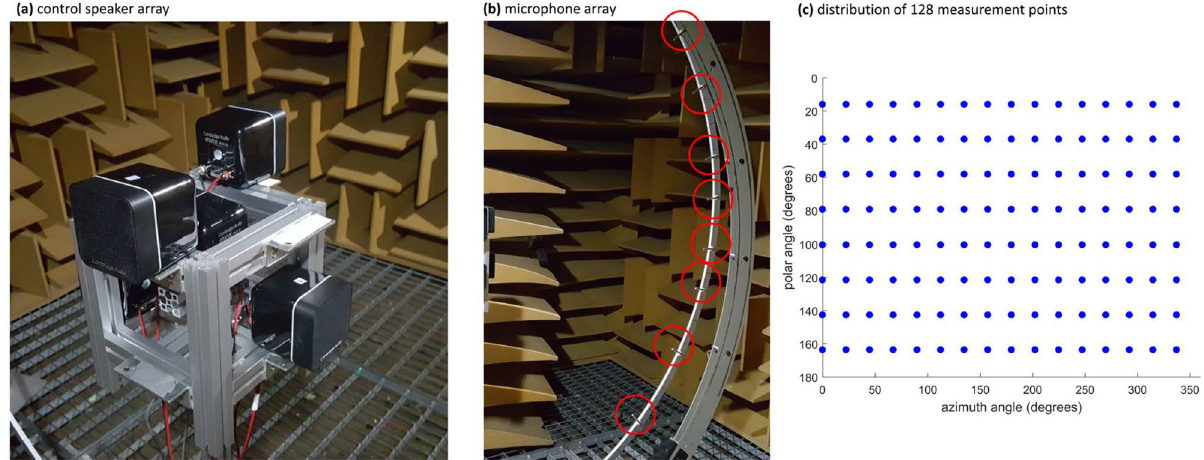
Figure 4. The experimental setting for controller design in an anechoic chamber and distribution of 128 measurement points. ( a ) Control speaker array; ( b ) Microphone array; ( c ) Distribution of 128 measurement points. Four control speakers were placed near the noise source at the vertex of a regular tetrahedron. Eight microphones (red circles) were rotated to measure acoustic power at a total 128 measurement points according to Gaussian sampling method. All 128 measurement points are 1 m away from the noise source.